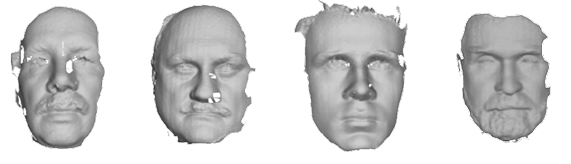
Figure 4. Face 3D models from unpaired dataset anthropological loss function L A during the CNN training to force the generator G to predict correct face 3D model.